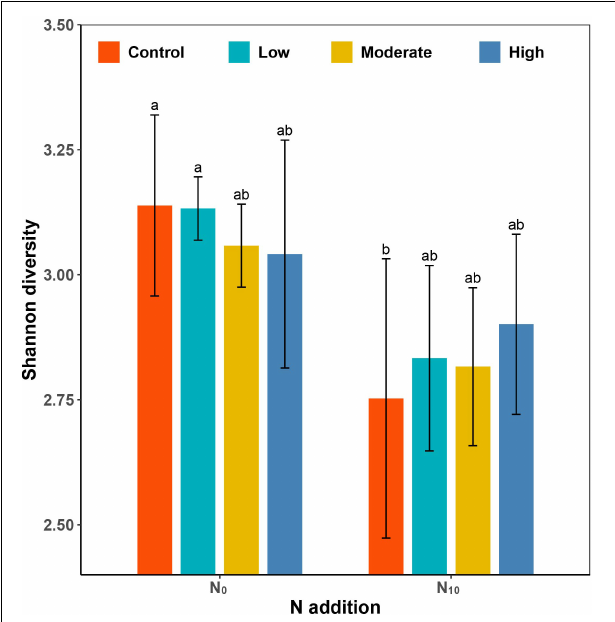
FIGURE 2 | Barplot showing the differences in Shannon diversity among fertilization (N 0 : control, N 10 : nitrogen addition) and clipping (i.e., control, low intensity, moderate intensity, high intensity) treatments. Values ( ± SE) are means of five replicates of each treatment. Different letters denote significant differences between treatments ( P < 0.05, Tukey’s HSD